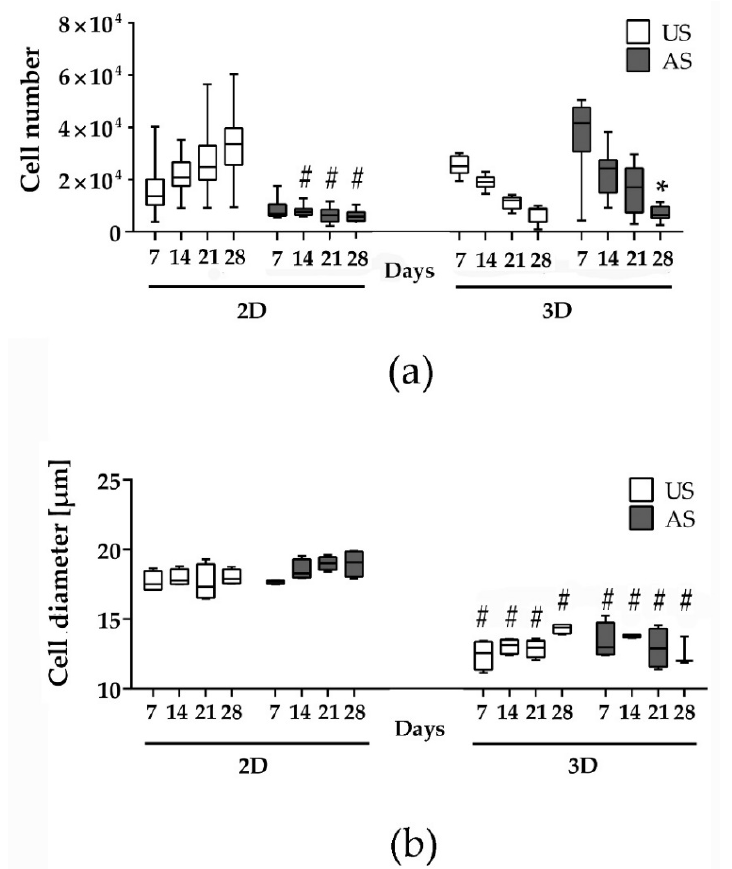
Figure 2. Quantification of the cell number and single cell diameter of adMSC in 2D and 3D cultures up to 28 days. ( a ) Cell number of unstimulated (US) and adipogenically stimulated (AS) adMSC within 28 days ( n = 9; # significantly different to US in 2D culture at the respective time point, Two-way ANOVA post hoc uncorrected Fisher´s LSD; # p < 0.05; * significantly different to day 7 of adipogenically stimulated 3D culture, Friedman test post hoc Dunn´s multiple comparison test, * p < 0.05). ( b ) Diameter of single cells under US and AS conditions in 2D and 3D culture ( n = 4; # significantly different from 2D culture at the respective time point, Two-way ANOVA post hoc uncorrected Fisher´s LSD; # p < 0.05).